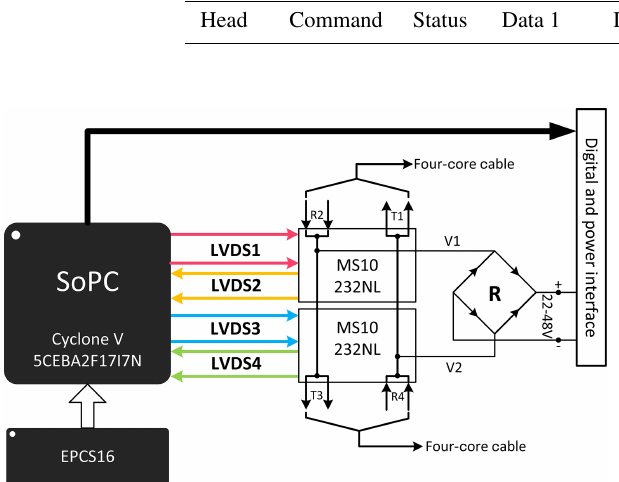
Figure 5. Block diagram of the main control data transmission board.